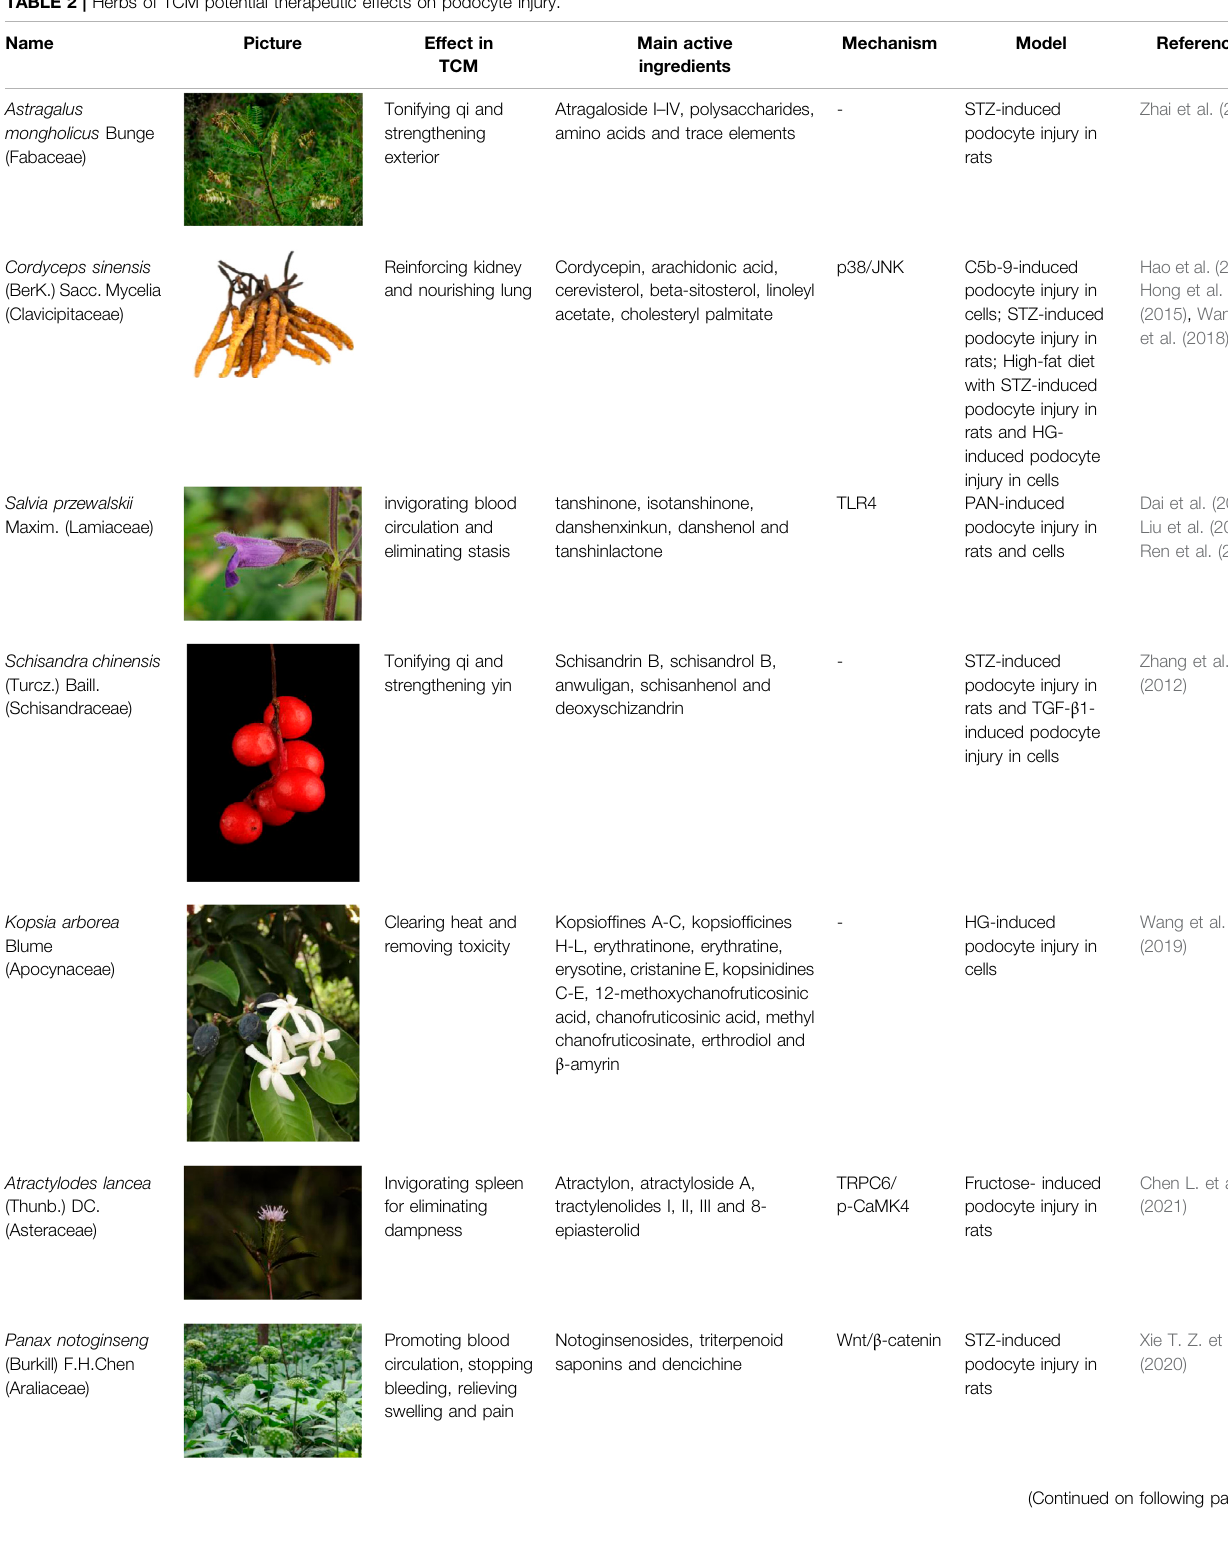
TABLE 2 | Herbs of TCM potential therapeutic effects on podocyte